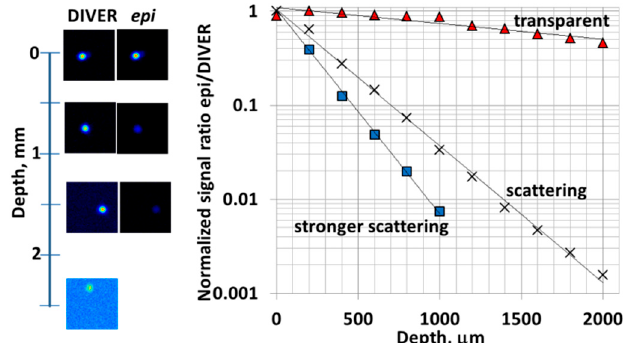
Figure 3. Comparison of the DIVER and the epi-detector efficiency. Images of fluorescent beads in scattering sample ( left ) and dependence of epi- to DIVER detector signals ratio on imaging depth ( right ). Samples measured: transparent (no TiO 2 particles added); scattering (scattering coefficient μ s = 3.5 mm − 1 ); stronger scattering ( μ s = 10 mm − 1 ).